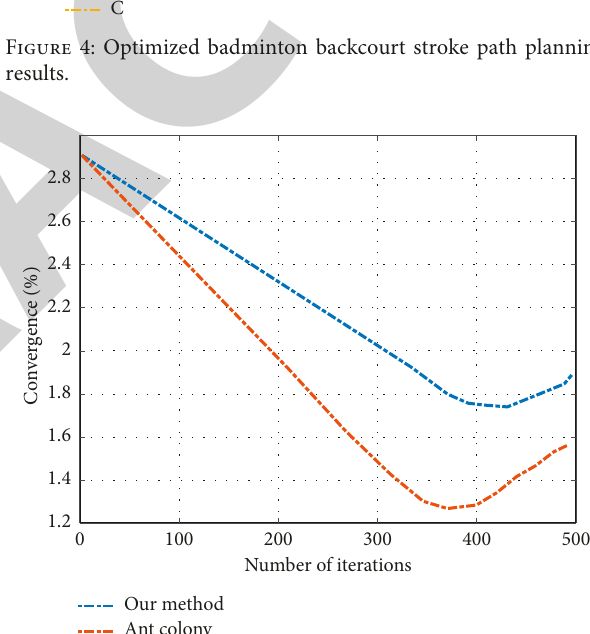
Figure 3: Original path of the badminton backcourt stroke.